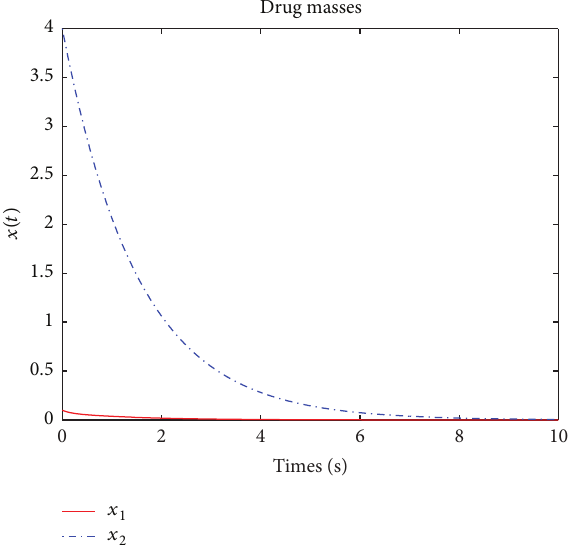
Figure 4: Time response of the biochemical network under positive